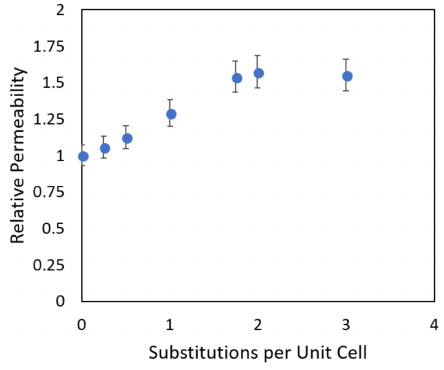
Figure 12. Relative permeability of MFI zeolite membranes at increasing levels of aluminum substitution.